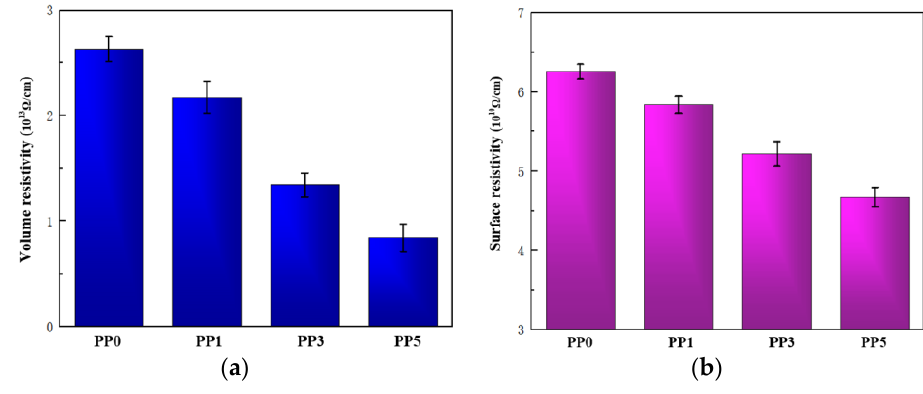
Figure 10. Resistivity of films. ( a ) Volume resistivity; ( b ) surface resistivity.